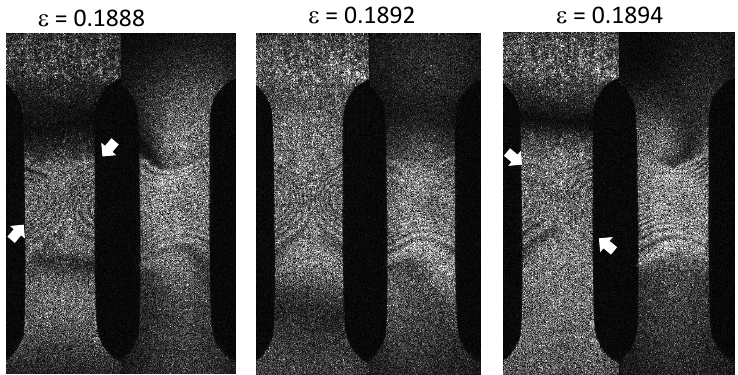
Figure 11. Shear band pattern changes